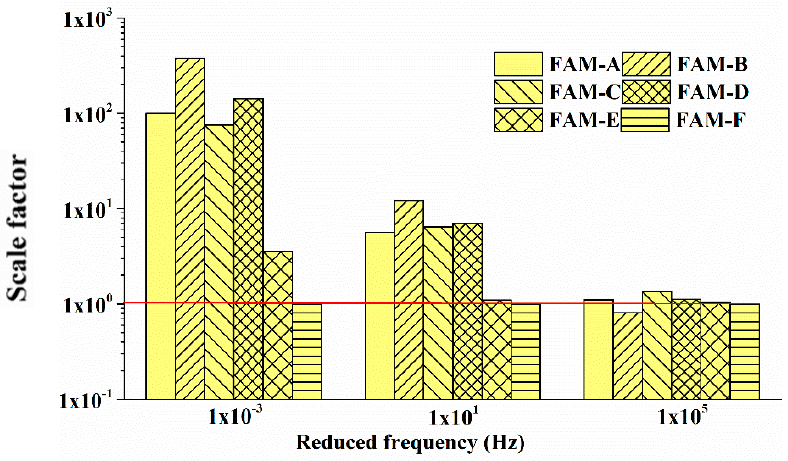
Figure 10. Scale factor of complex modulus at three kinds of frequency.